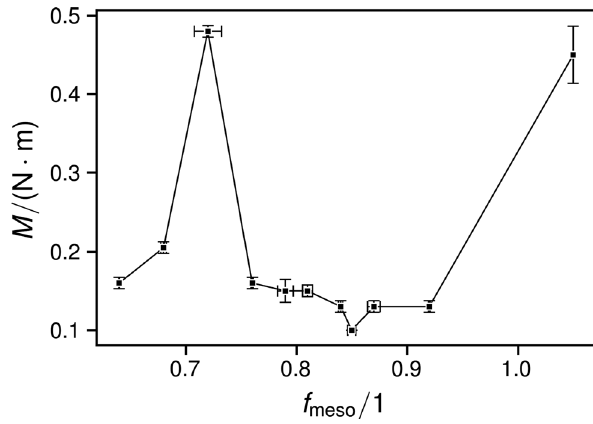
Figure 10: Medians of the momenta required for constant rotational speed of the extruder ’ s twin - screw.